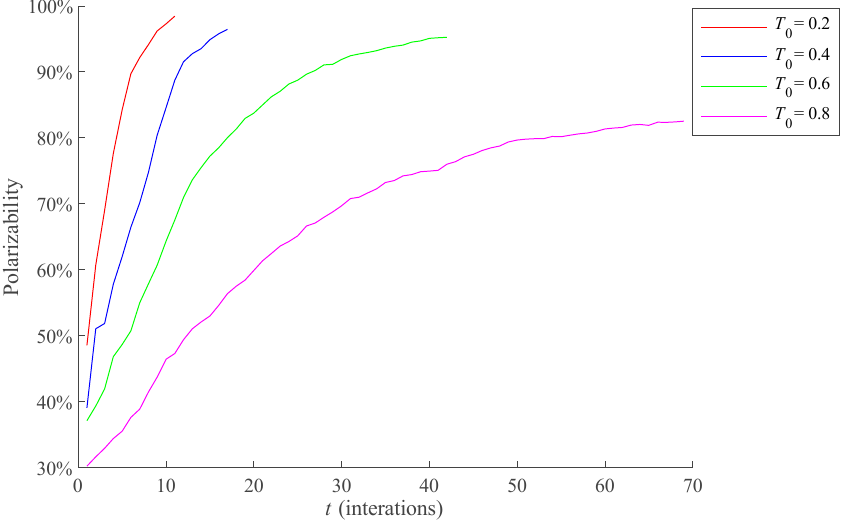
Figure 11. Influence of the different T 0 on the polarization process of public